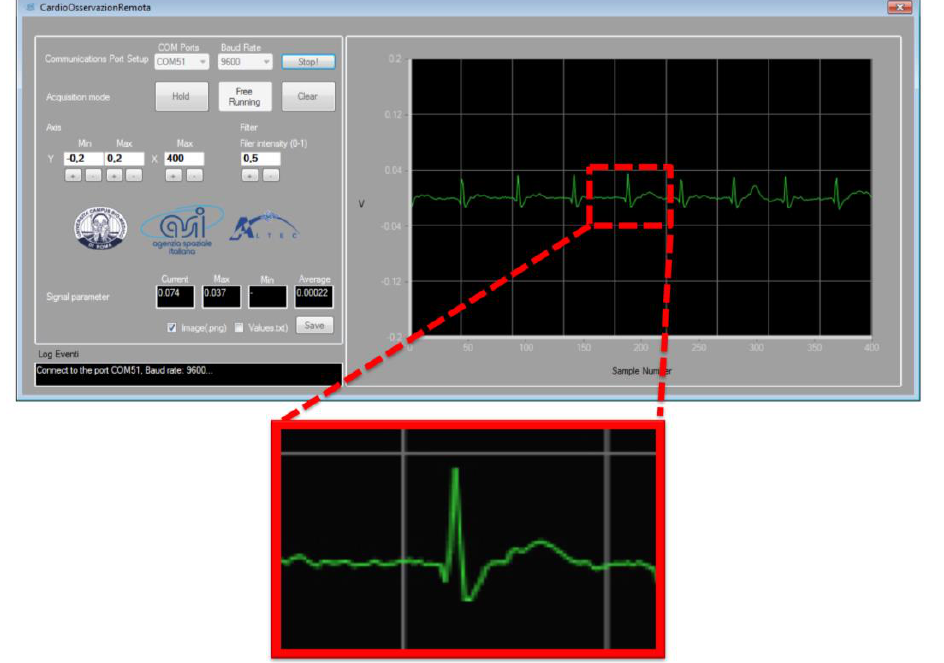
Figure 11. Heart signal recordings (two electrodes placed on the t-shirt of one of the ten control individuals tested). The ECG-like signal is displayed in real time on the window of the dedicated SW. The detail in the zoom put in evidence that the wave T and the complex QRST can be easily identified, while the P wave is often confused with similar artefacts.